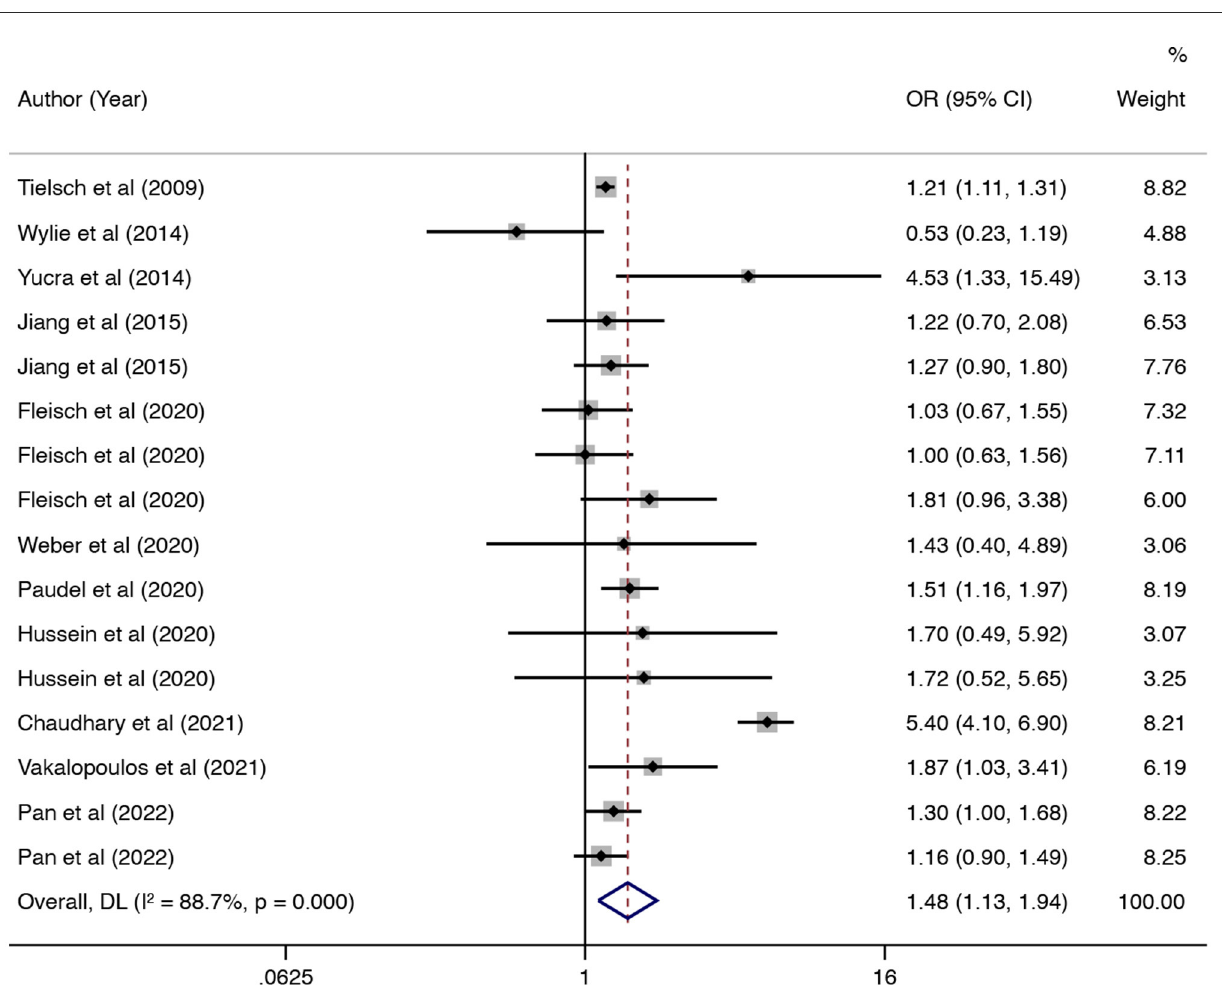
FIGURE3 Forest plot showing the effect of polluting cooking fuels on small for gestational age